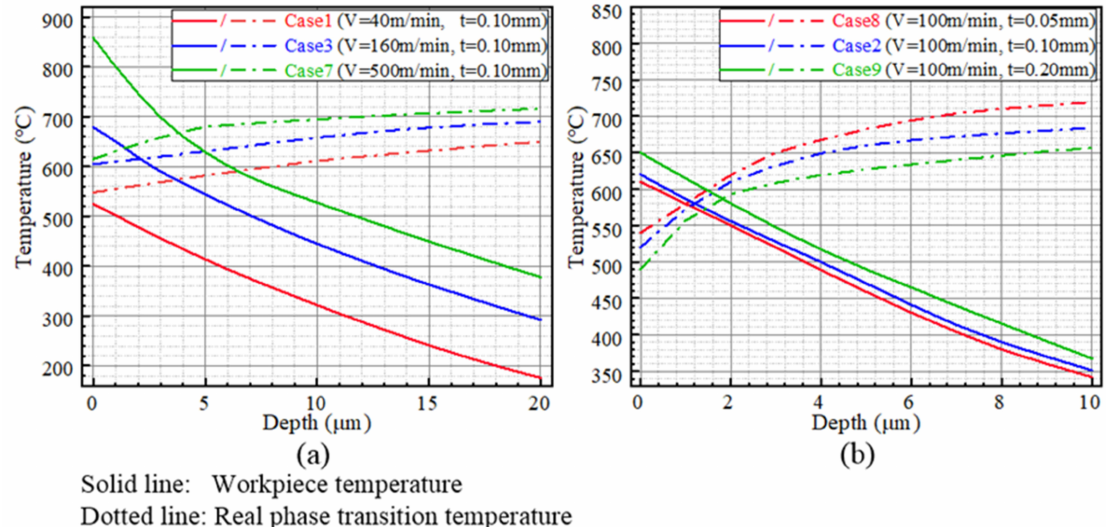
Figure 15. Evaluation of white-layer thickness: ( a ) The relationship between temperature and cutting speed, ( b ) The relationship between temperature and cutting